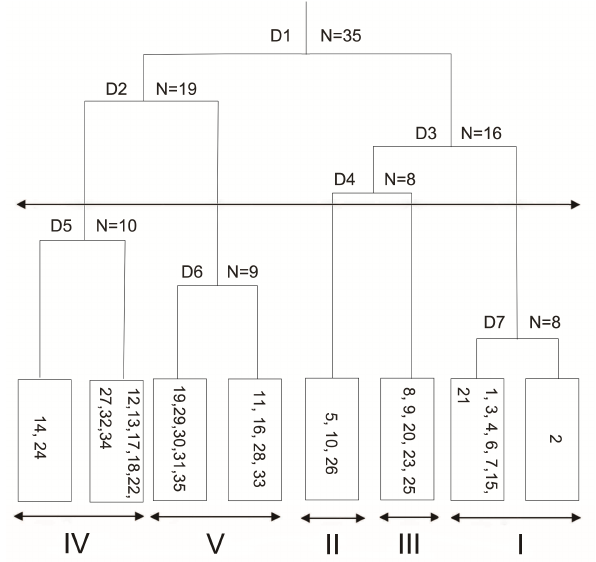
Figure 2. The dendrogram of the sampling sites based on the TWINSPAN classification. Note: numbers 1–35 represent the site numbers of the sampling sites, D indicates the classification levels and N indicates the number of sampling sites for the classification. I to V represent communities I to V. Arrows indicates that all the sites were divided into five major groups after the fourth classifica-